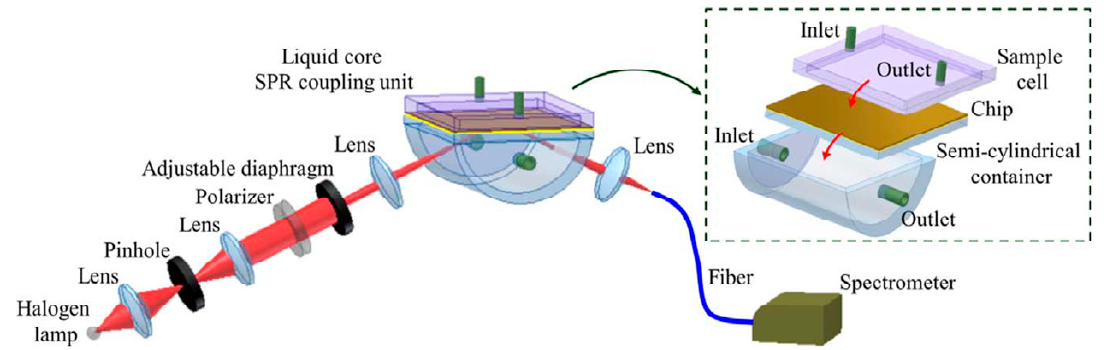
Figure 1. Example of fluidic SPR measurement. Reproduced with permission from [4]. Copyright (2018) Elsevier BV.